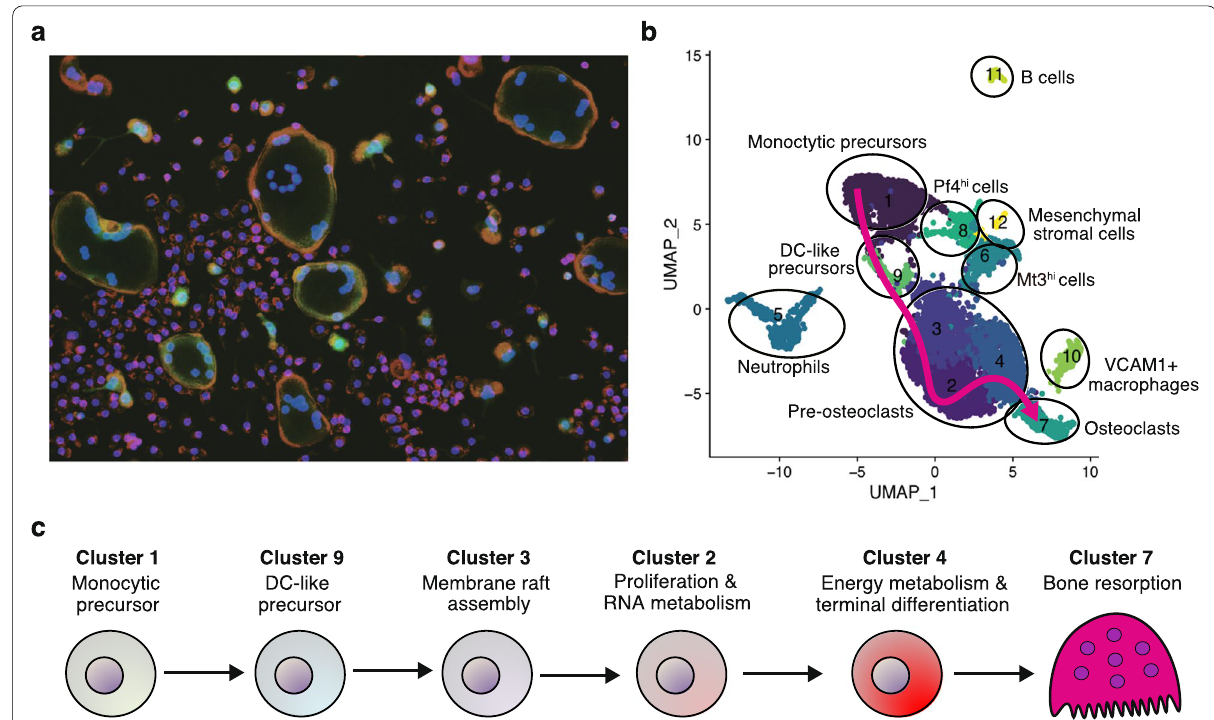
Fig. 3 Single-cell landscape of osteoclastogenesis. a Representative image of osteoclast differentiation culture system after 3 days of RANKL stimulation in bone marrow cells from CtsK-Cre CAG-CAT-EGFP mouse. The multinucleated giant cells labeled with EGFP are osteoclasts. Most of the cells in the culture system failed to differentiate into mature osteoclasts. Green (EGFP), CTSK; red, actin; blue, DAPI. b The osteoclast differentiation trajectory estimated by pseudotime analysis using the scRNA-seq data obtained from the in vitro osteoclast culture system. c Schematic of the stepwise cell fate decision pathways during osteoclastogenesis unveiled by